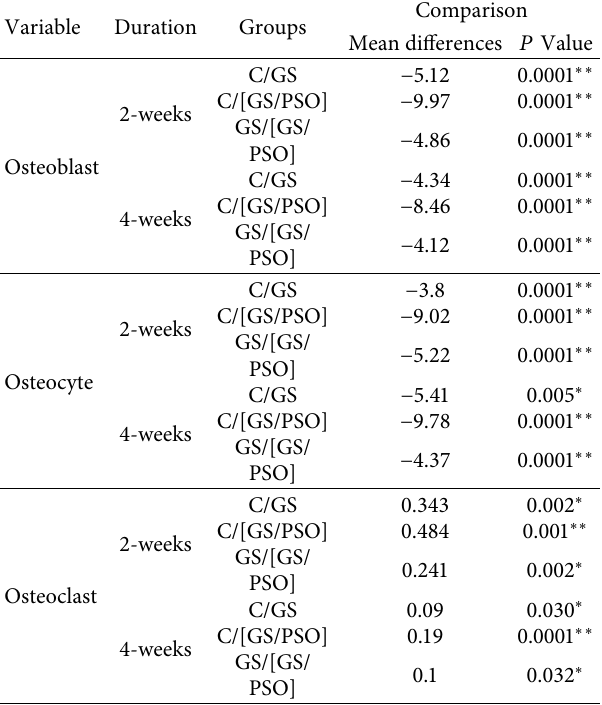
Table 3: Group comparison for bone cells at 2- and 4-weeks. Table 4: Group comparison for TN, TA, and BMA at 2- and 4-